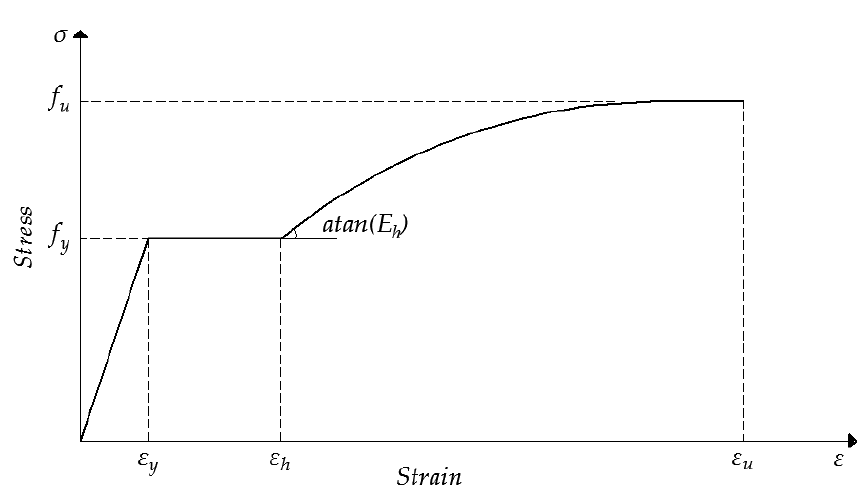
Figure 4. The steel stress-strain model.